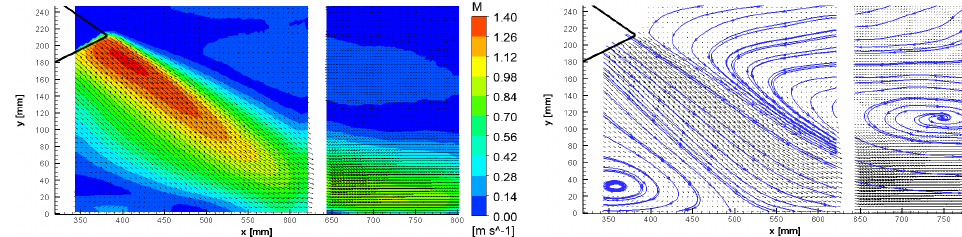
Figure 14. PIV measurements, the magnitude of time-averaged 2D velocity (left panel) and vector lines in vertical plane ( z = 75mm ) .